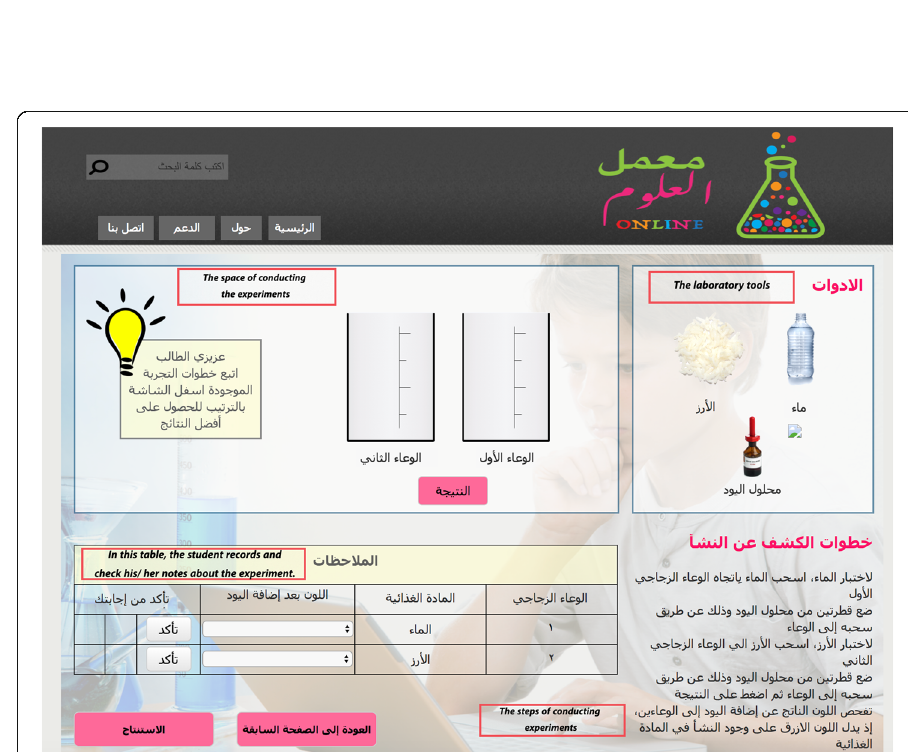
Fig. 5 Screenshot of an experiment ’ s interface on the